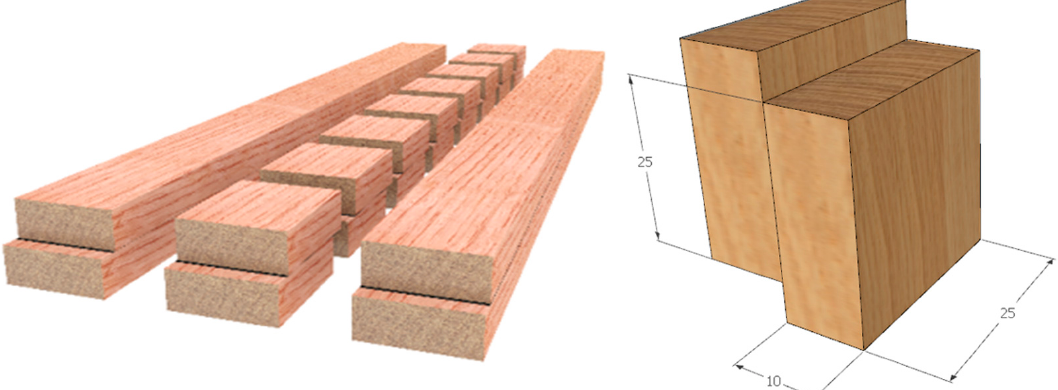
Figure 1. The preparation of material assemblies and the geometry of test specimens according to ISO 6238:2018. All dimensions are in mm.